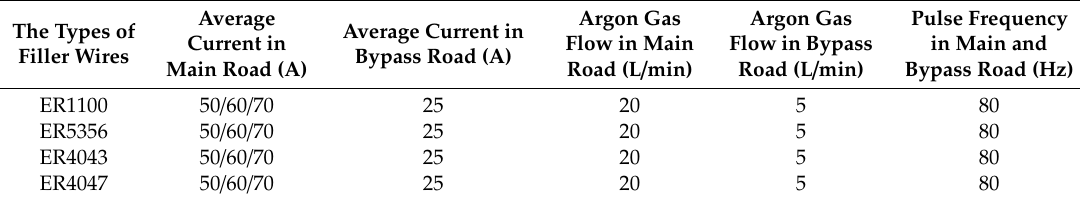
Table 4. Welding